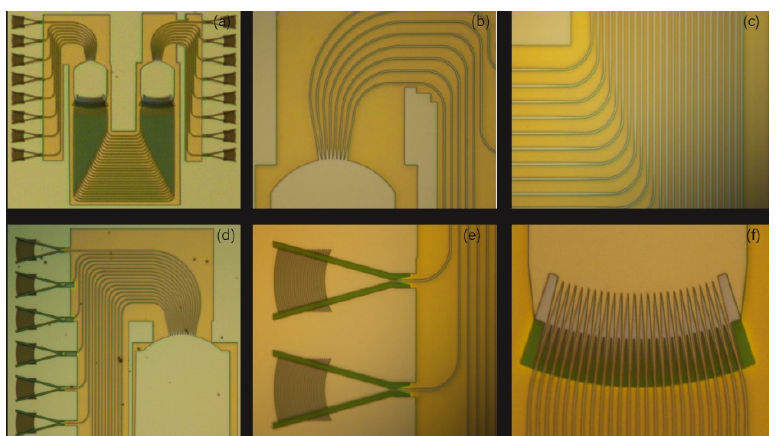
Figure 7. Microscope photo of ( a ) fabricated 8 × 8 AWG; ( b ) output waveguides; ( c ) arrayed wave- guides; ( d ) input waveguides; ( e ) grating coupler; ( f ) the tapers between input/output waveguides and FPR.